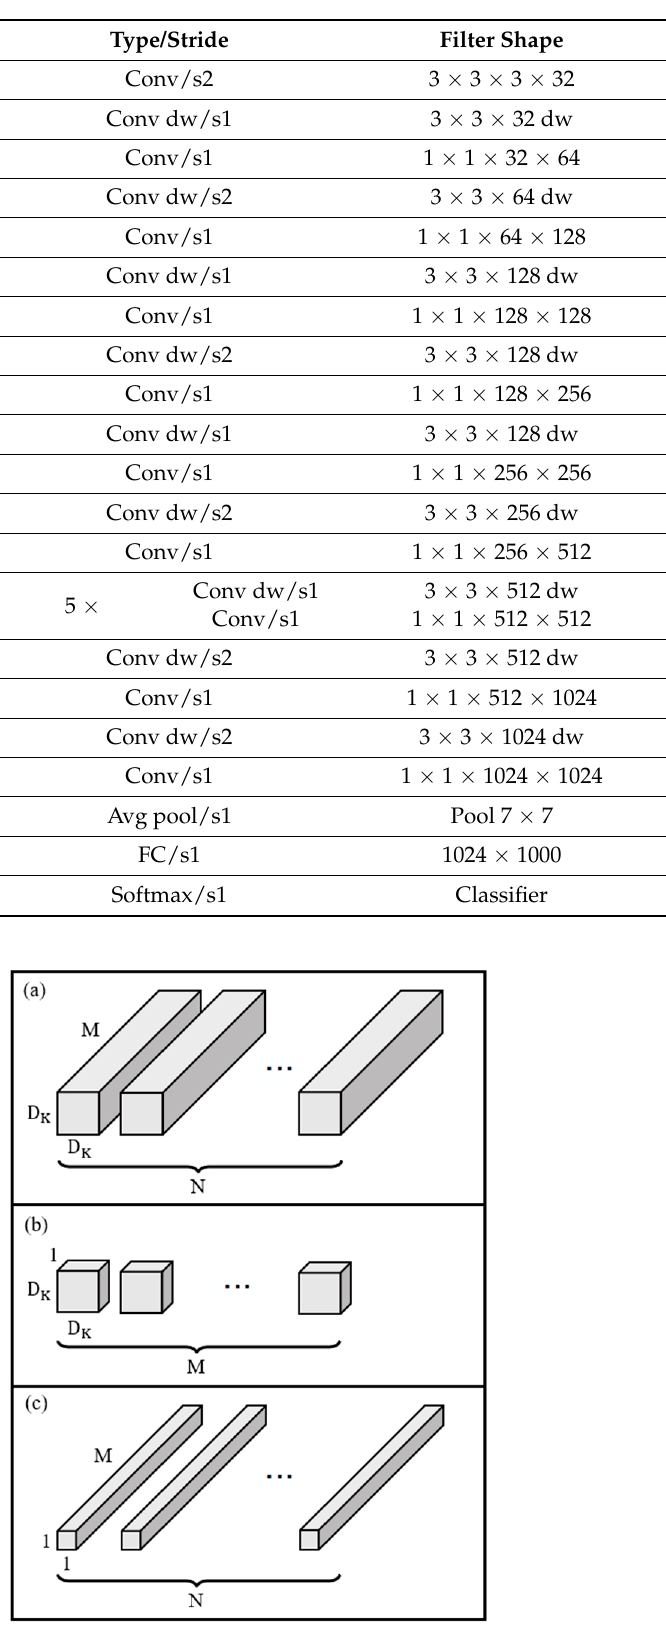
Table 3. Architecture of MobileNet v1 [13].